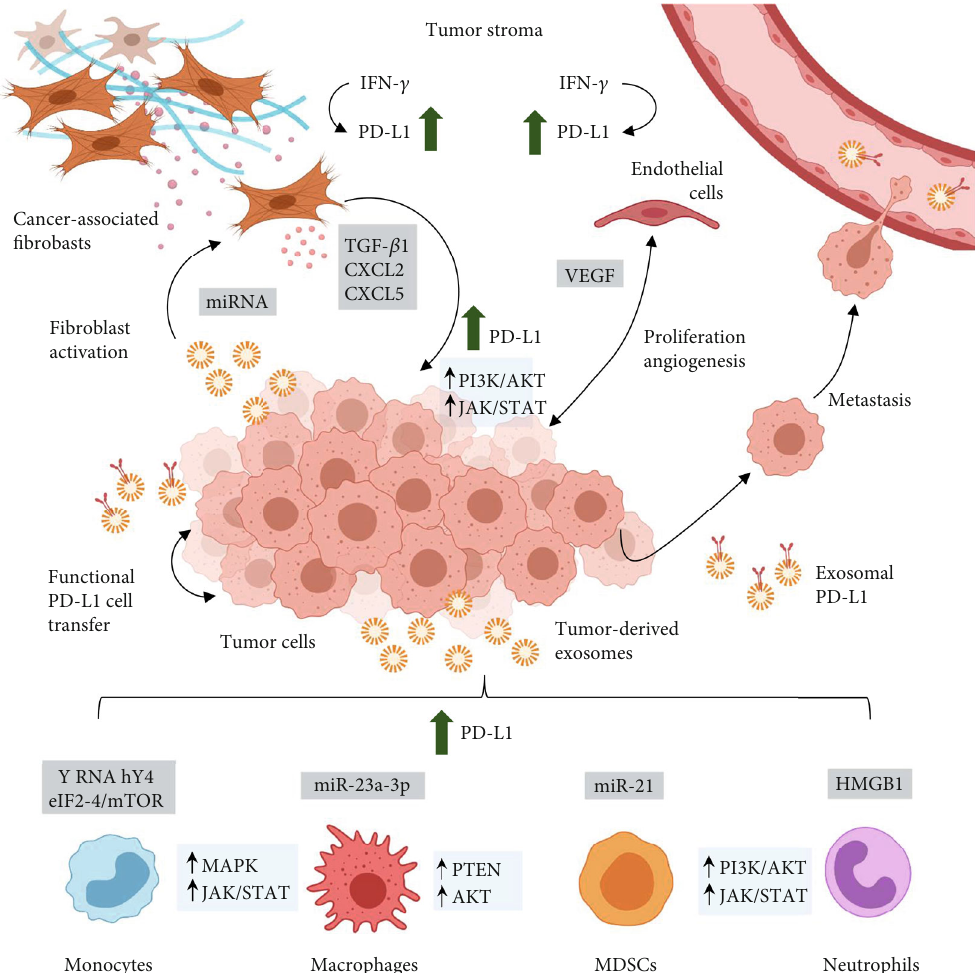
Figure 3: A macroscopic overview at the molecular crosstalk mediated by tumor-derived exosomes and exosomal PD-L1 in the TME. Exosomal PD-L1 mediates functional PD-L1 transfer between cells and induces systemic immunosuppression to facilitate metastasis. Tumor-derived exosomes induce the PD-L1 expression in monocytes, macrophages, myeloid-derived suppressor cells (MDSCs), and neutrophils via regulatory proteins and microRNA (gray boxes) which upregulate MAPK and JAK/STAT signaling (blue boxes). Cancer- associated fi broblasts and endothelial cells also express PD-L1 in response to interferon- γ (IFN- γ ). Tumor-derived exosomes induce fi broblast activation which in turn results in the release of soluble factors that increase tumor PD-L1 expression. Likewise, tumor cells and endothelial cells interact to sustain a protumoral TME via soluble factors, such as vascular endothelial growth factor